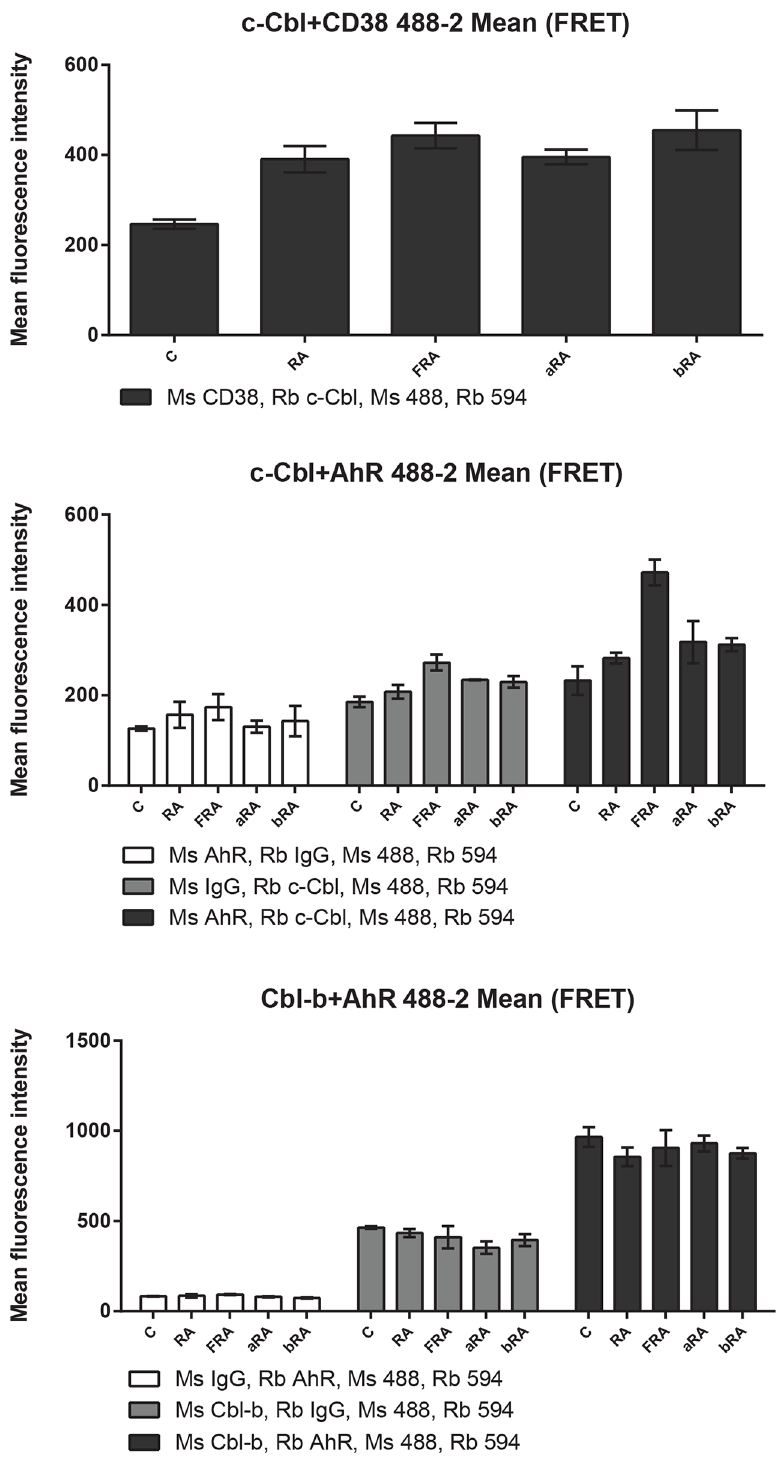
Fig 9. FICZ induces a c-Cbl-AhR association (mean fluorescence). HL-60 cells were initiated in culture at 0.1 x 10 6 cells/ml with 1 μ M RA, 100 nM FICZ, 1 μ M α -NF and 1 μ M β -NF as indicated. Cells were harvested, fixed for 10 min with 2% paraformaldehyde, and permeabilized with ice cold methanol. Cells were labeled with the primary antibodies (or isotype controls) and then stained with Alexa 488- and 594-conjugated goat anti-mouse and goat anti-rabbit secondary antibodies, respectively (Invitrogen). The immunocomplexes were analyzed using flow cytometry (BD FACS ARIA III SORP, BD Biosciences). Mean fluorescence intensity is shown.